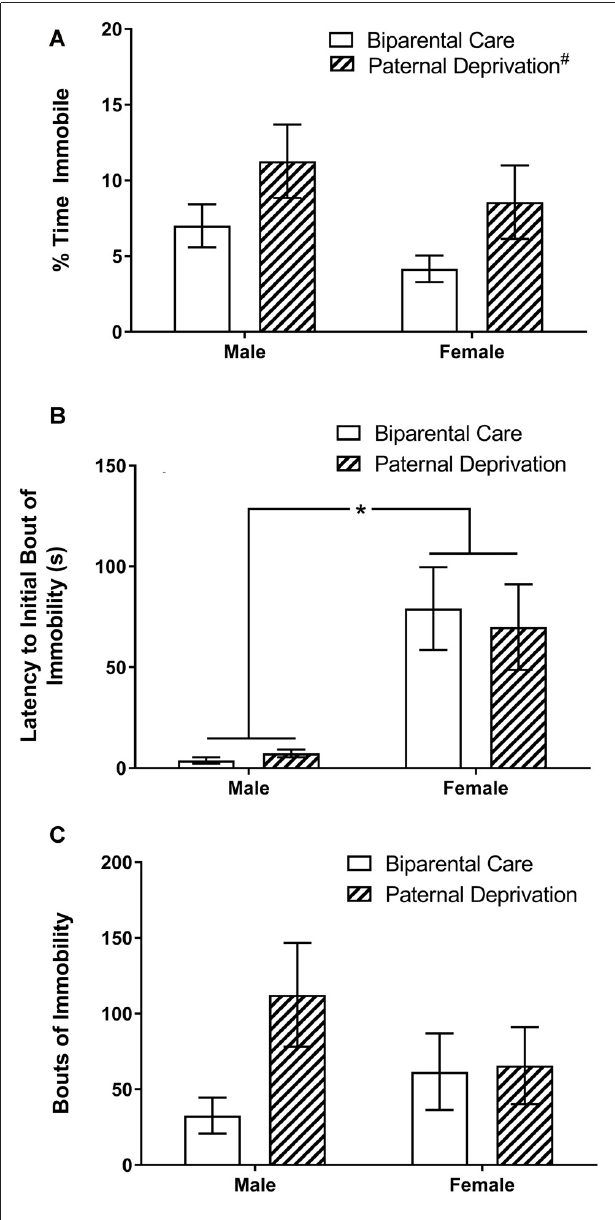
FIGURE 5 | Both rearing and sex alter indices of passive stress-coping behavior during the forced swim test in young adult California mice. Male and female California mice were reared by both parents (biparental care) or by the mother alone [paternal deprivation (PD)] from postnatal day (PND) 1 until weaning. On PND 67, mice underwent a 5 min forced swim test. (A) Overall, PD increases % time immobile. #, main effect of PD. (B) Irrespective of rearing, males display immobility faster than females. ∗ p ≤ 0.05. (C) Neither sex, nor rearing, alter bouts of immobility. N sizes: biparental care male, 8; biparental care female, 7; PD male, 5; PD female, 6. Bars represent mean ±